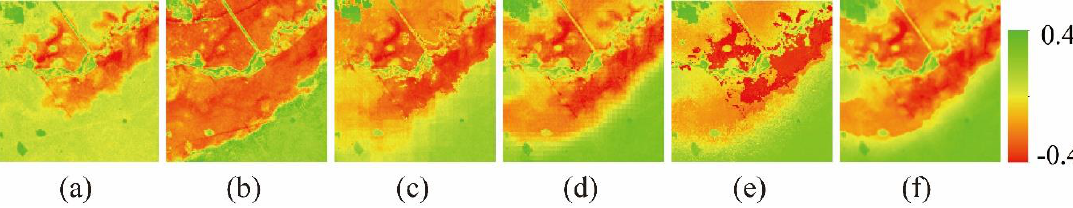
Figure 11. Visual comparison of the flood area. ( a , b ). The original Landsat_NDVI on 26 November and 12 December 2004; ( c – f ). Predicted Landsat_NDVI by ESTARFM, NDVI-LMGM, FSDAF and NDVI_FMHC.